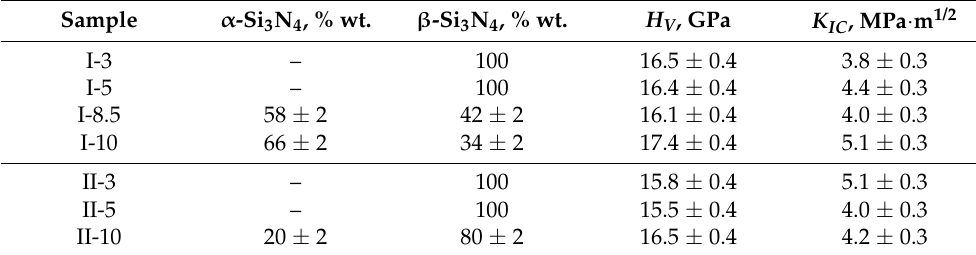
Table 3. Phase composition and mechanical properties of the ceramic